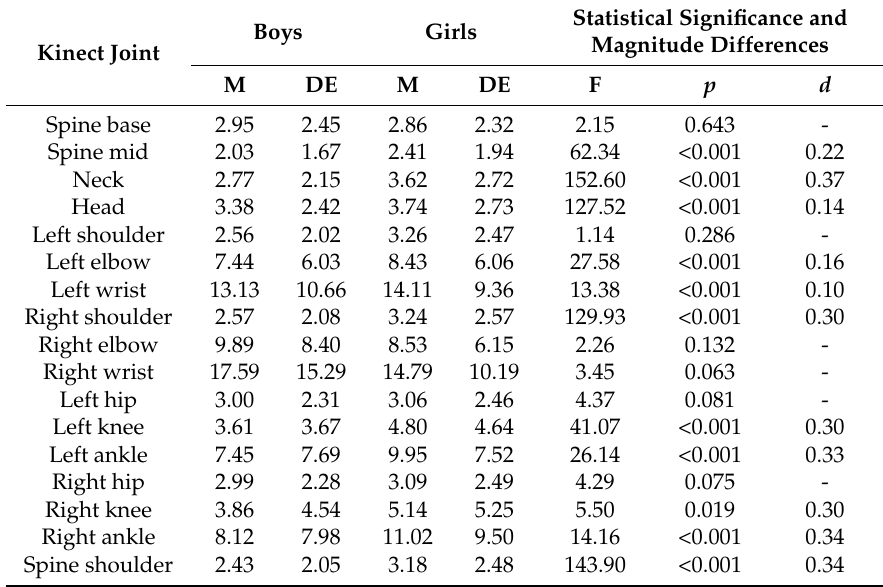
Table 3. Average differences in movement for every joint in the experimental group, according to sex.